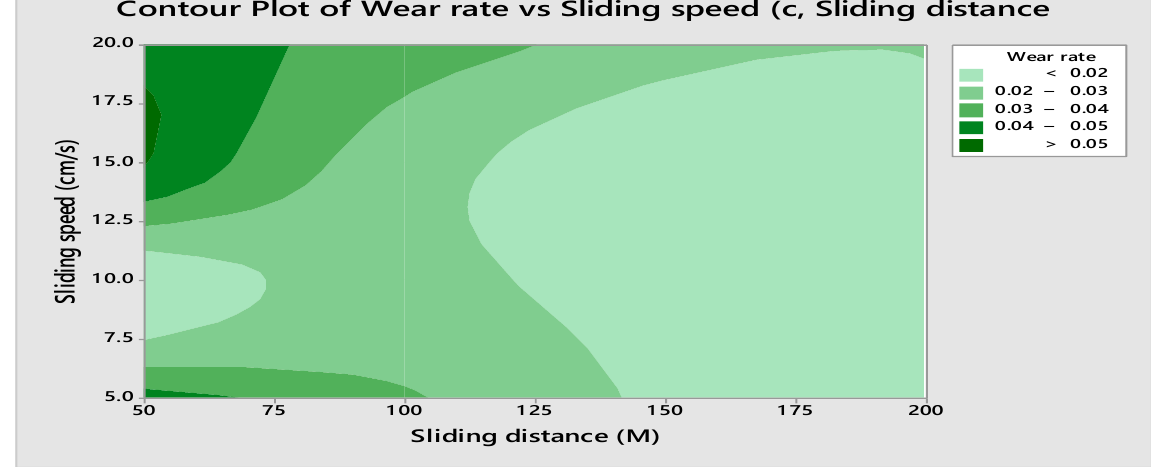
Figure 6: Wear Map 3 shows the lowest wear rate at sliding speed, 10cm/s and sliding distance,